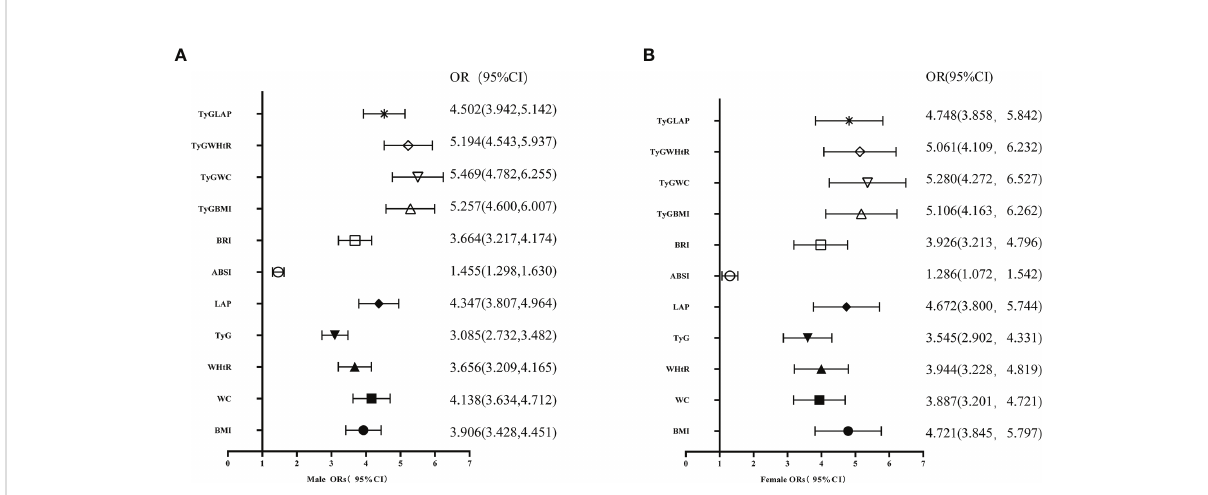
FIGURE 1 (A) Multivariate logistic regression OR values adjusted for age, SBP, and DBP,BUN, Cre, ALT,AST,TC, and LDL-C in males. (B) Multivariate logistic regression OR values adjusted for age, SBP, and DBP,BUN, Cre, ALT,AST,TC, and LDL-C in females.OR and 95% con fi dence interval for the incidence of hyperuricemia in the high versus low quartile of obesity markers, TyG and its derivatives. The multivariate adjusted OR were adjusted for age, SBP, DBP, BUN, Cre, ALT,AST,TC, and LDL-C; CI, con fi dence intervals; TyG, triglyceride and glucose index; BMI, body mass index; WC, waist circumference; WHtR, waist-to-height ratio; AIP, atherogenic index of plasma; CMI, cardiometabolic index; VAI, visceral adiposity index; LAP index, lipid accumulation product index; ABSI, a body shape index; BRI, body roundness index. TyGBMI,TyG-BMI =TyG×BMI; TyGWC, TyG-WC=TyG×WC; TyGWHtR ,TyG-WHtR=TyG×WHtR; TyG-LAP,TyG-LAP=TyG×LAP.